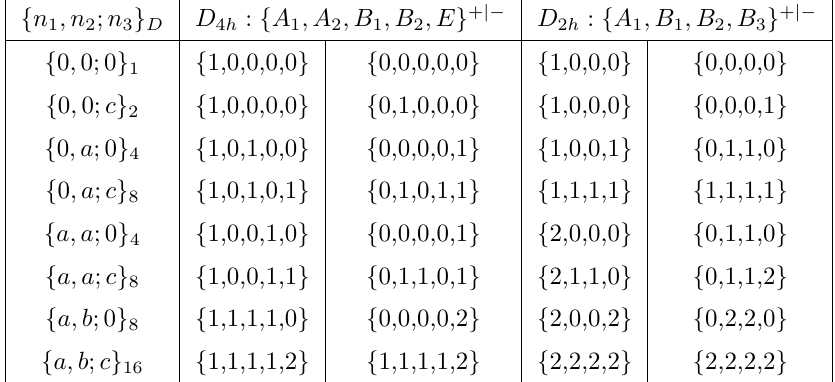
Table 4 . Different patterns for the representation spaces { n 1 , n 2 ; n 3 } and the multiplicity of irreps in such patterns for the D 4 h and D 2 h groups. a , b and c are non-zero numbers with a 6 = b . The numbers in the last four columns are the multiplicities of the corresponding irreps in different representation